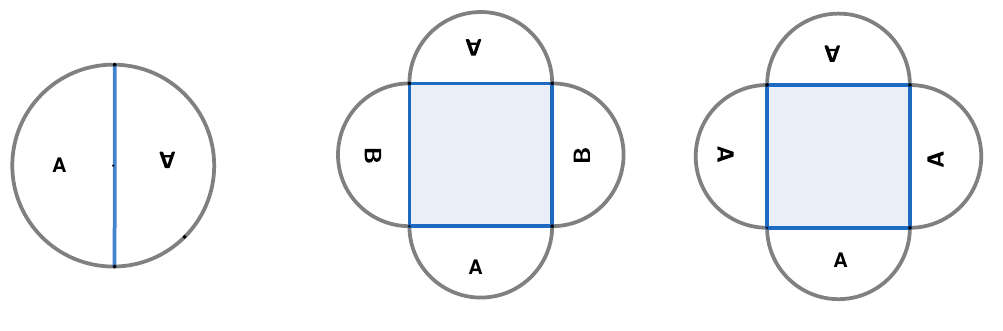
Figure 3 . All the quadrangulations invariant under some